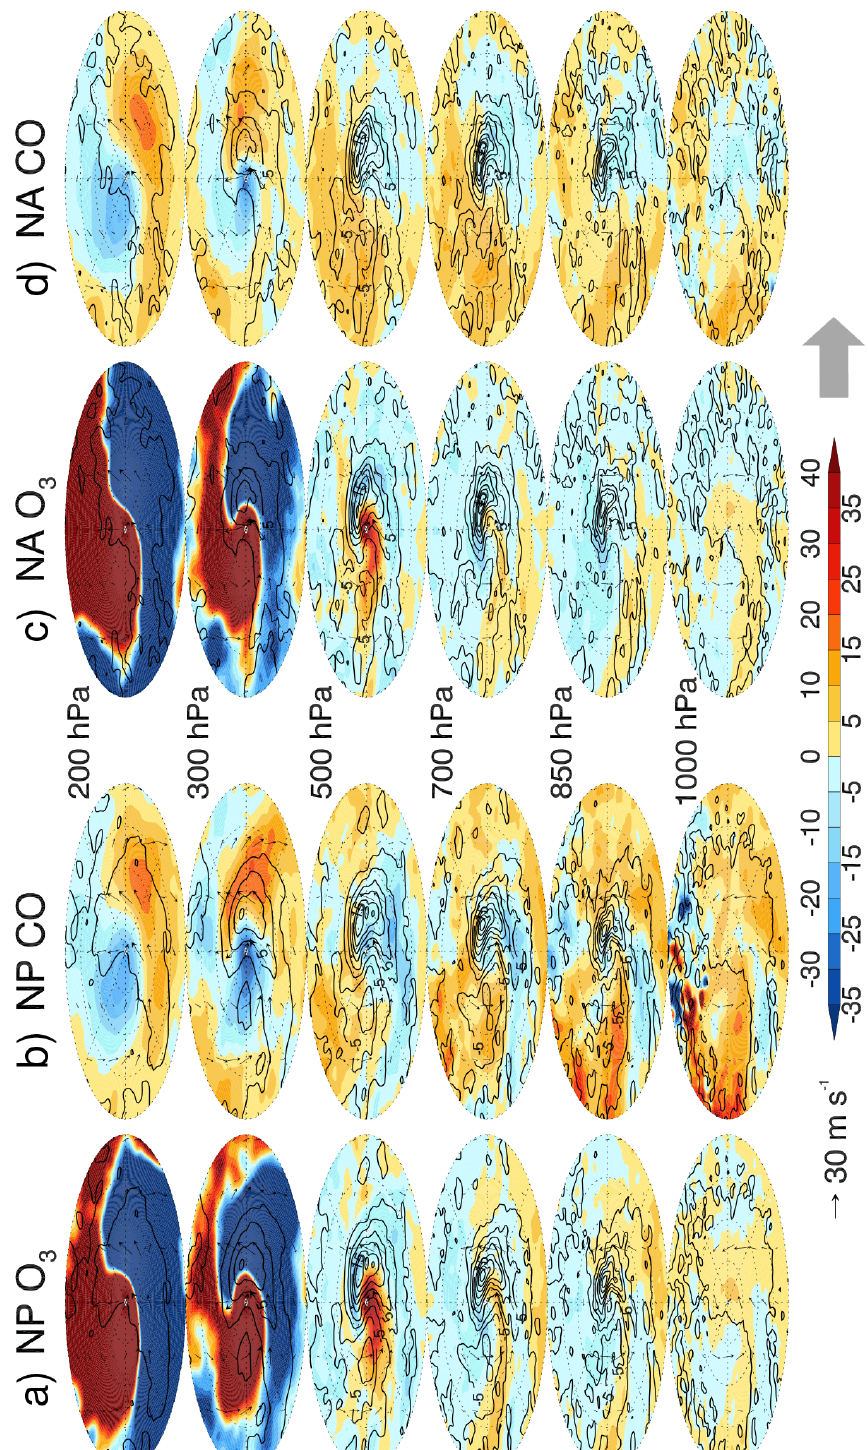
Figure 6. (a, c) O 3 and (b, d) CO anomalies (ppb) of the (a, b) NP and (c, d) NA storm-centered composite (Fig. 4) minus the background composite (Fig. 5) with ω storm-centered minus background anomalies (black contour lines; 4hPah − 1 contour